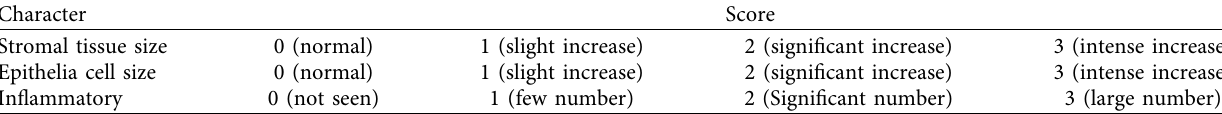
Table 1: Histopathological characteristic aspect.